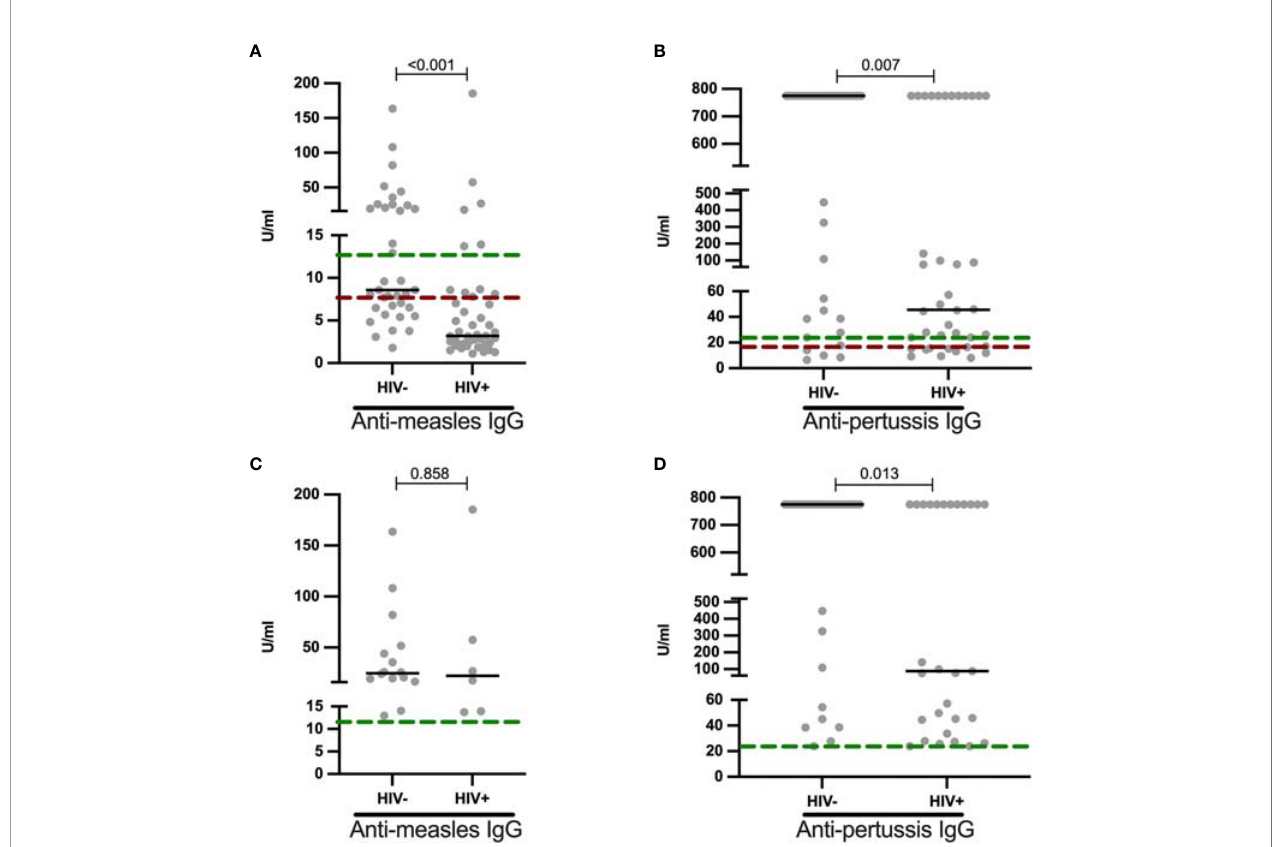
FIGURE 3 | Reduced anti-measles and anti-pertussis plasma IgG titers in HIV+ children: (A) Anti-measles (U/ml) and (B) anti-pertussis (U/ml) IgG titers are shown for HIV negative and HIV positive children. Individuals with positive (C) anti-measles (U/ml) and (D) anti-pertussis (U/ml) IgG titers are shown and strati fi ed by HIV status. Titers above green dotted line are termed as positive, those between green and red dotted lines as equivocal and those below the red line as non-responses. Each dot represents an individual volunteer, the median is indicated. Statistical analysis was performed using the Mann-Whitney U-test.